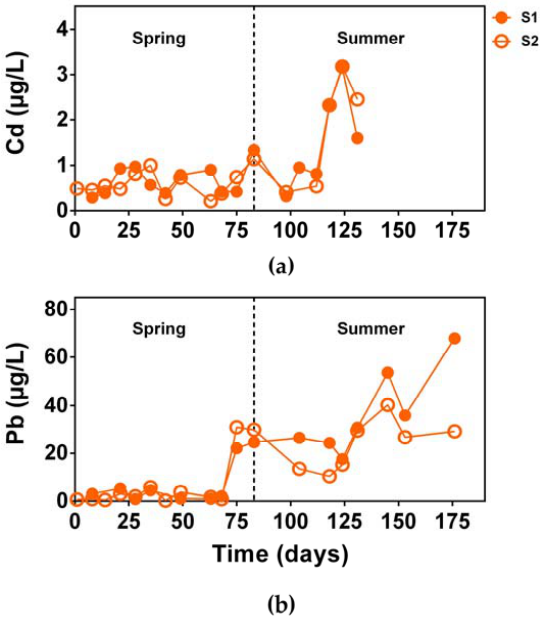
Figure 10. Concentration of trace metals in influent (S1) and effluent (S2) surface water along the monitoring performed in the pilot site from spring to summer 2012: ( a ) Cd and ( b ) Pb.